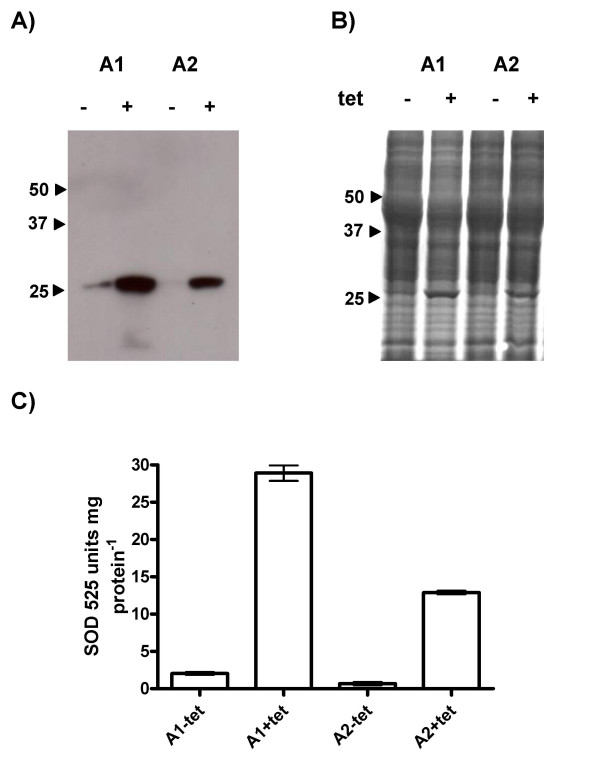
Inducible expression of TcSOD A. Two clones containing pTcINDEX-SOD A9E10 on a CL-Brener [pLEW13] background were induced with 0.25 μg ml-1 tetracycline for five days. Replicate cultures were grown in the absence of tetracycline. Protein extracts were made and analysed by SDS-PAGE, western blotting and enzyme assay. A) Western blot of a gel stained with the mouse monoclonal 9E10. A single band of approximately 25 kDa was recognised by the antibody. B) Coomassie stained SDS-PAGE gel showing lysates from control and induced populations of clones A1 and A2. Note the intense band appearing in the induced lanes, at the position of the band recognised by the antibody in A. C) Relative SOD activities of the trypanosome lysates as measured using the SOD 525 assay system. Each assay was performed in triplicate. Clone A1 showed a 14:1 ratio of SOD activity between induced and uninduced cells, while clone A2 showed an 18:1 ratio.